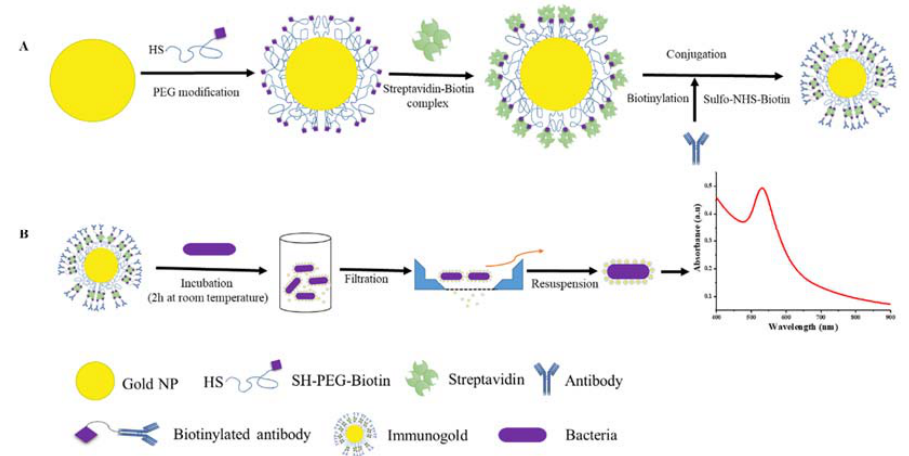
Figure 1. ( A ) Schematic of the functionalization route for PEG ‐ grafted gold nanoparticles and conjugation with anti ‐ C. sakazakii IgG via streptavidin ‐ biotin coupling; ( B ) the resulting immunogold nanoparticles specifically bind to C. sakazakii after incubation. A fast and simple centrifugation and filtration step makes the specifically labeled bacteria detectable with plasmon extinction spectroscopy.